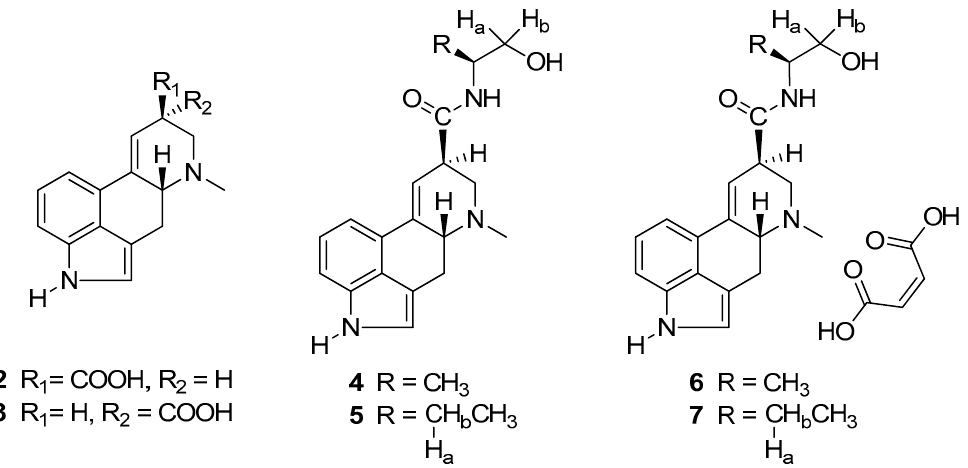
Figure 2. Structures of d -lysergic ( 2 ), d -isolysergic acid ( 3 ), ergometrine ( 4 ), methylergometrine ( 5 ), ergometrine maleate ( 6 ), and methylergometrine maleate ( 7 ).